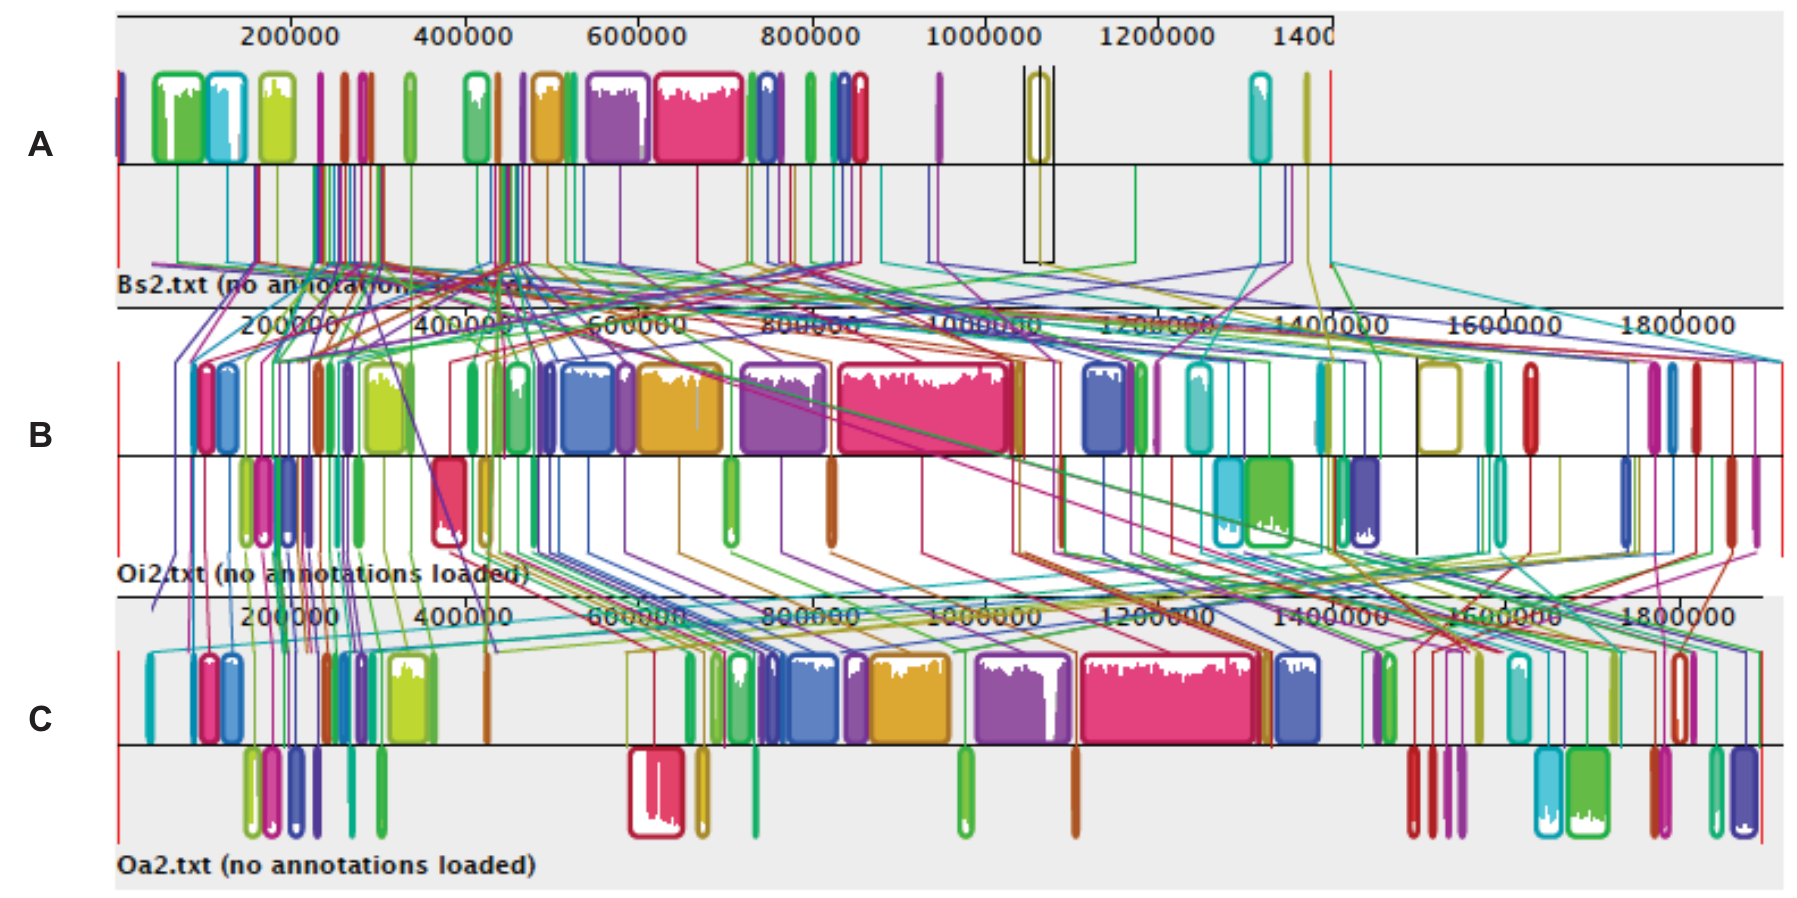
Figure 3. Gene alignment of small chromosome (ChrII) of B. suis , O. intermedium and O. anthropi using MAUVE multiple alignments. Colored outlined blocks surround regions of the genome sequence that aligned to part of another genome. The colored bars inside the blocks are related to the level of sequence similarities. Lines link blocks with homology between two genomes. Genome from top to